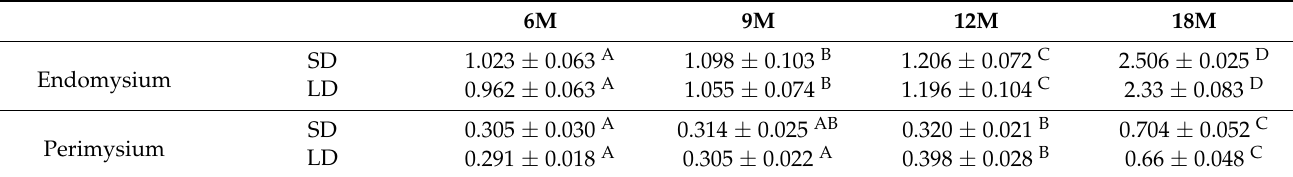
Table 4. The content of pyridinoline in intramuscular connective tissues of Semitendinosus (SD) and Longissimus dorsi